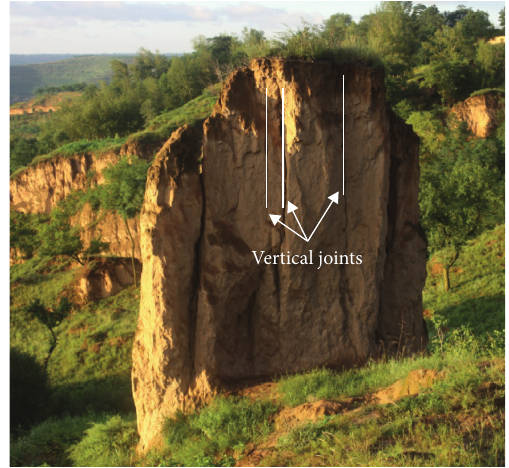
Figure 2: Typical vertical joints developed in late Pleistocene.